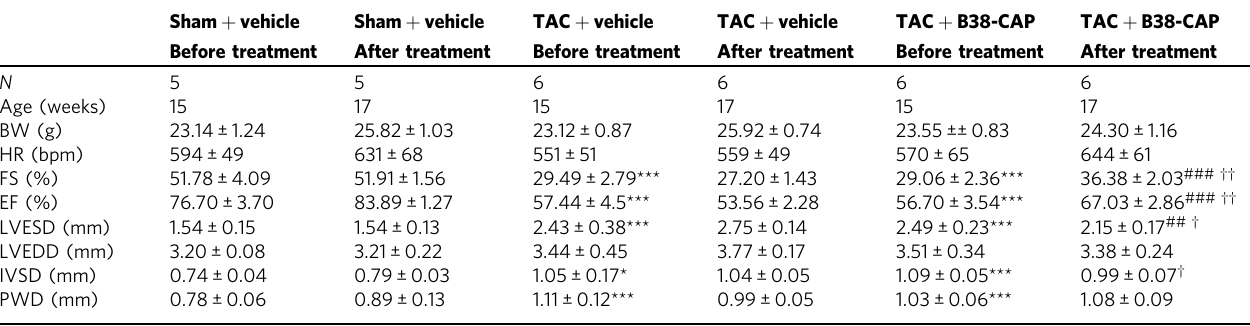
Table 3 Echocardiographic parameters in the mice with established cardiac dysfunction treated with B38-CAP for 2 weeks. Sham + vehicle Sham + vehicle Before treatment After treatment Before treatment After treatment Before treatment After